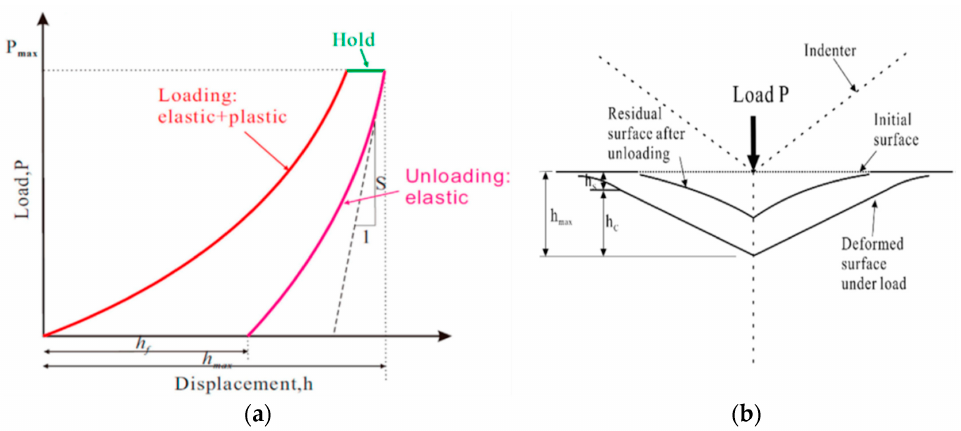
Figure 3. Schematic illustration of the nano-indentation test. ( a ) Typical indentation load-displacement curve, Reproduced with permission from [20,21], Elsevier, 2019; ( b ) unloading process, Reproduced with permission from [22], Cambridge University Press,